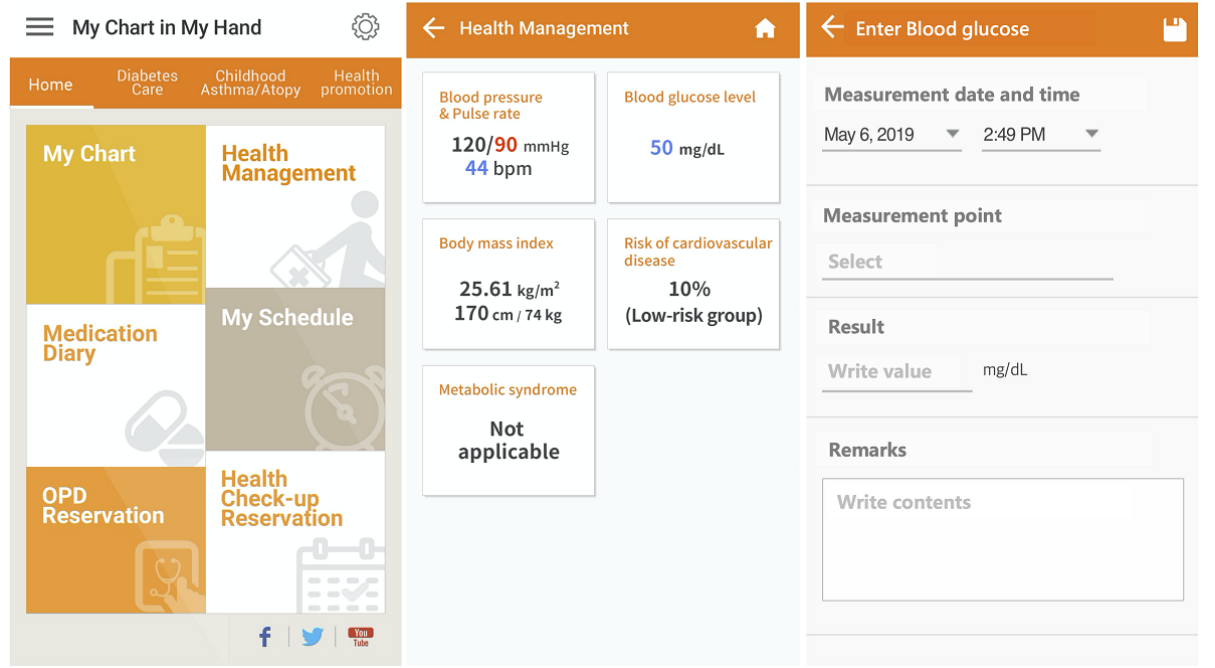
Figure 1. Screenshots of My Chart in My Hand version 2.0. Inputting data in the sugar function follows from the home page to Enter Blood